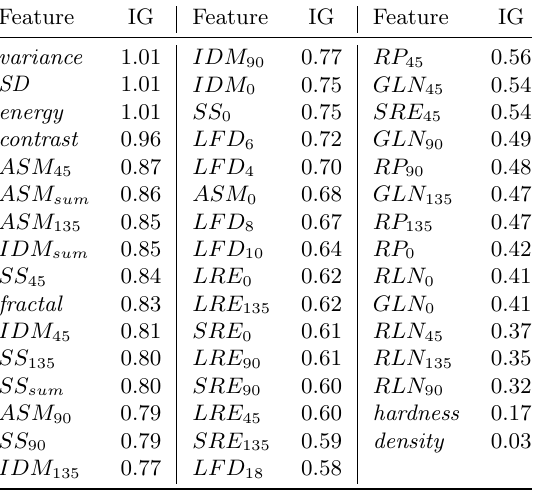
Table 1. Information gains of features [bit] sorted in descending order from top-left to